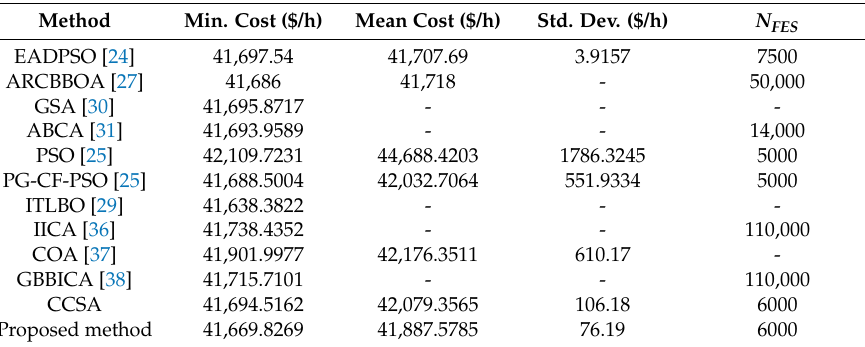
Table 9. The result comparison for case